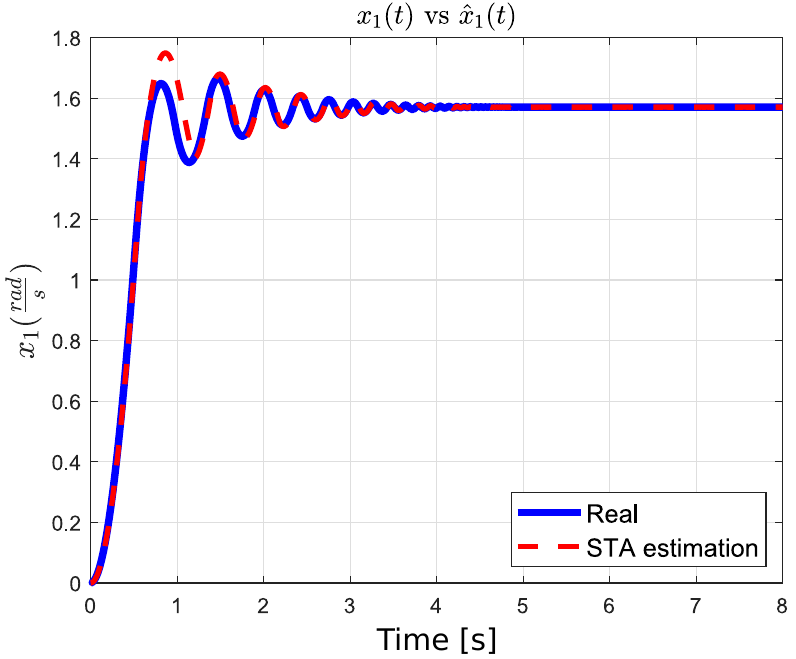
Figure 5. Comparison between the proposed Lyapunov function and Equation